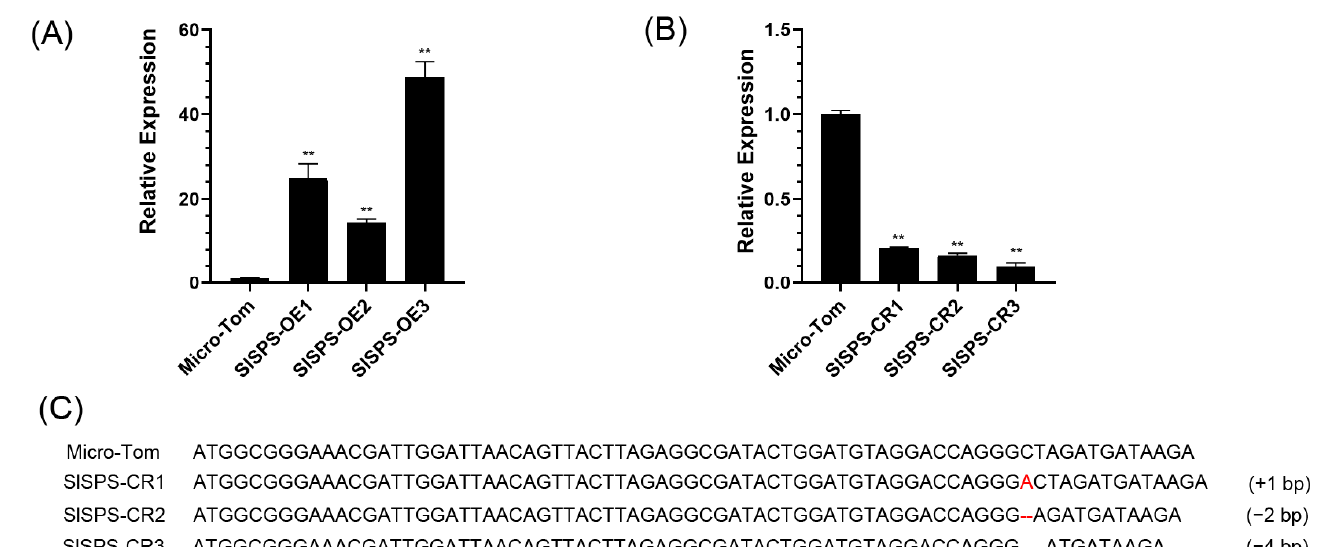
Figure 1. Expression level of SlSPS gene in over-expression lines (SlSPS-OE1, SlSPS-OE2 and SlSPS- OE3) ( A ) and knock-out lines (SlSPS-CR1, SlSPS-CR2 and SlSPS-CR3) ( B ). ** p < 0.01, comparisons with Micro-Tom plants using Student’s t -tests. Target sites of SlSPS coding sequence in the knock-out lines ( C ). Nucleotide or dash in red denotes insertion or deletion in the corresponding site. 3.2. Effects of Over-Expression and Knock-Out of SlSPS Gene on Plant Phenotypes To evaluate the effects of the expression of SlSPS gene on plant phenotypes, several phenotypic traits of transgenic plants were analyzed at different stages. At the seedling stage (2-week, 3-week, 4-week) and flowering stage, the over-expression plants were larger than plants, while the knock-out plants were smaller (Figure 2A–D). At the two-week seedling stage, growing under light condition, the root length of over-expression plants was longer than that of Micro-Tom plants, and the root length of knock-out plants was shorter (Figure 3A,B). At the four-week seedling stage, the height, fresh weight and dry weight of knock-out plants were significantly lower than those of wide-type plants (Figure